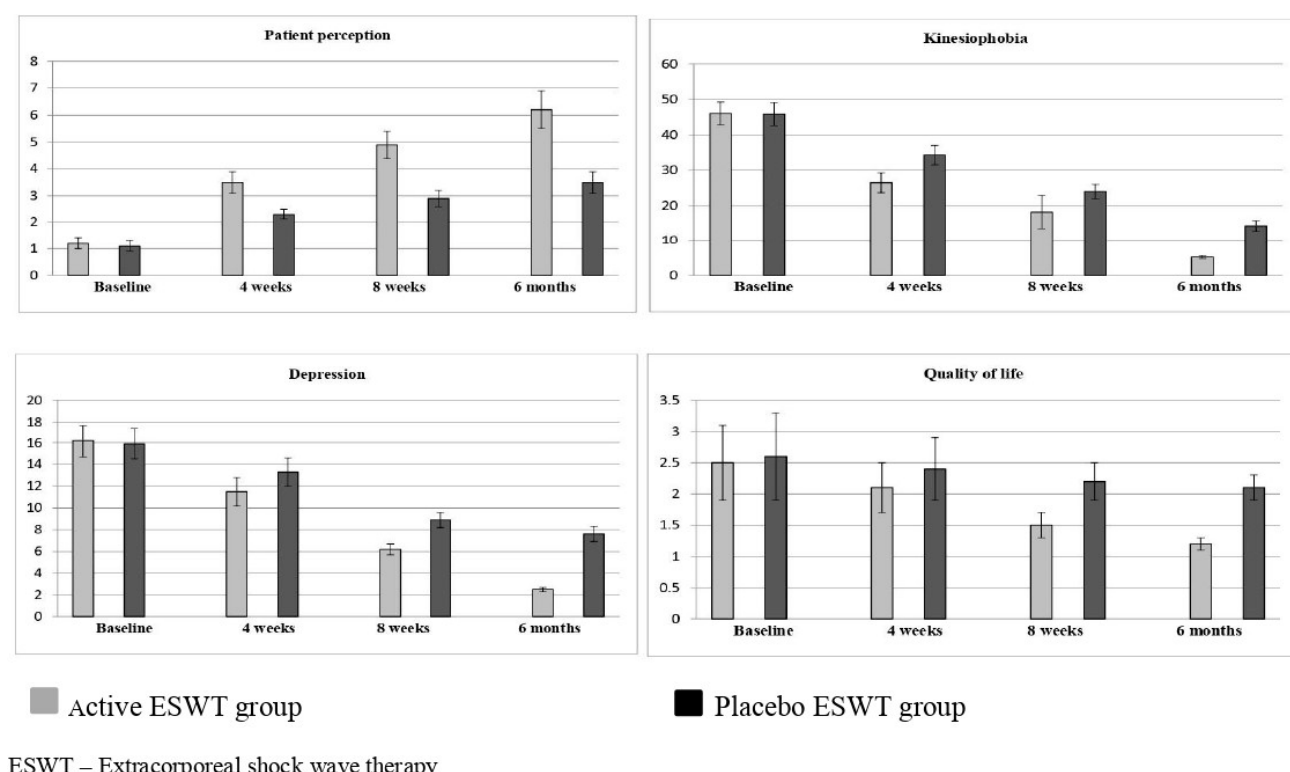
Figure 3. Pre- and post outcome measures of active and placebo ESWT groups.